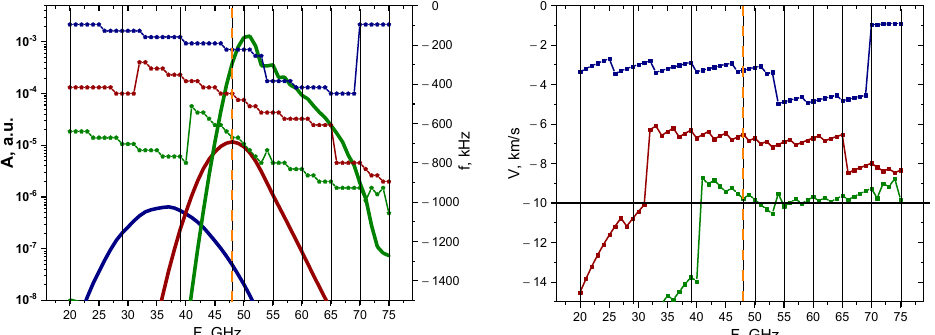
Figure 31. For the poloidally stretched filament with an amplitude of 0.1%: ( left ) dependency of the